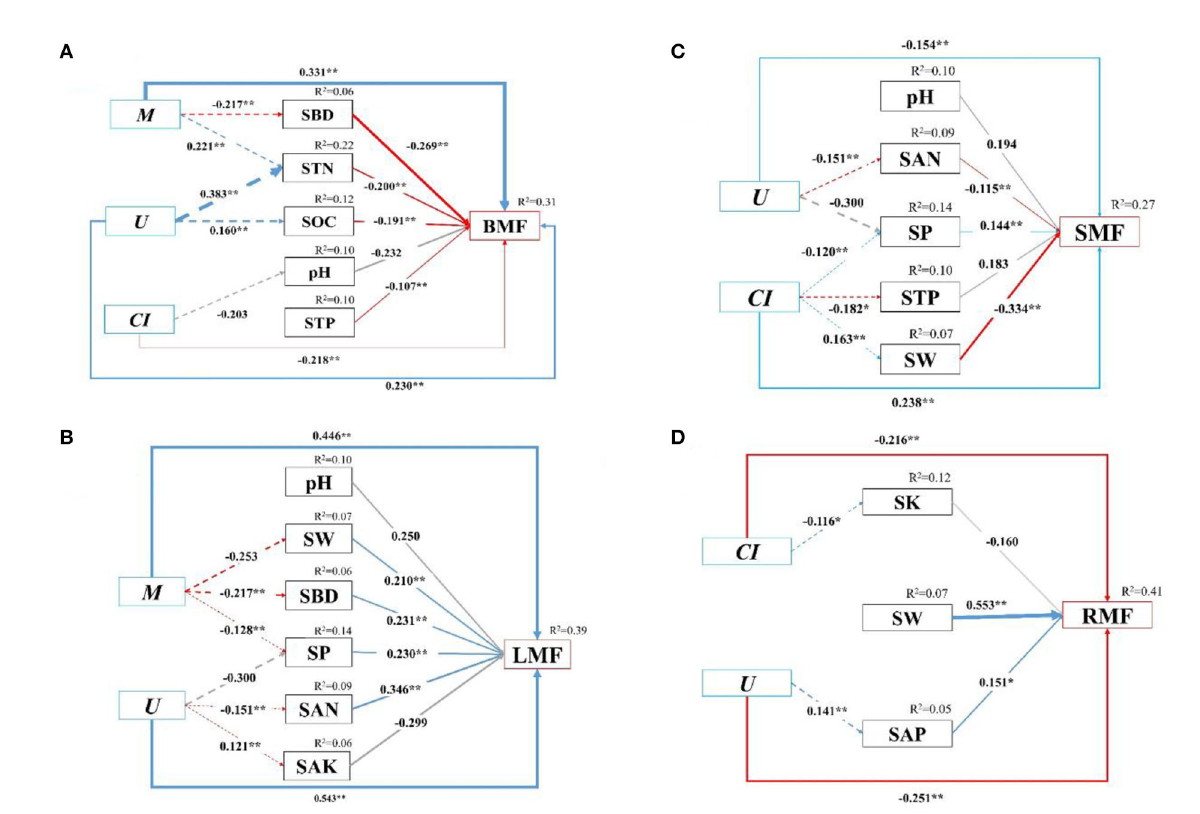
FIGURE7 (A–D) The structural equation model (SEM) among biomass allocation of organs, stand spatial structure characteristic indexes, and environmental factors. Chi-square ( χ 2 ) = 97.72, DF = 112, Chi/DF = 0.873, GFI = 0.948, NFI = 0.938, PGFI = 0.672, RMSEA = 0.015, AIC = 363.720, p = 0.102. The solid and dashed arrow are the direct and indirect pathways, respectively. The blue and red arrow represent significant positive and negative effects, respectively. The gray dashed arrows represent no significant pathways. The thickness of the arrows is proportional to the magnitude of the standardized path coefficients. The arrow width is proportional to the strength of the relationship. The growth indexes are C/R ratio, crown-root ratio; H/D ratio, height-diameter ratio; and SQI, seedling quality index. The stand spatial structure parameters are M , mingling index; W , uniform angle index; CI , competition index; U , neighborhood comparison; and O , opening degree. The soil parameters are SOC, soil organic carbon; STN, soil total nitrogen; SAN, soil alkaline nitrogen; STP, soil total phosphorus; SAP, soil available phosphorus; SK, soil total potassium; SAK, soil available potassium; SW, soil water content; pH, soil pH; SBD, soil bulk density; SP, soil